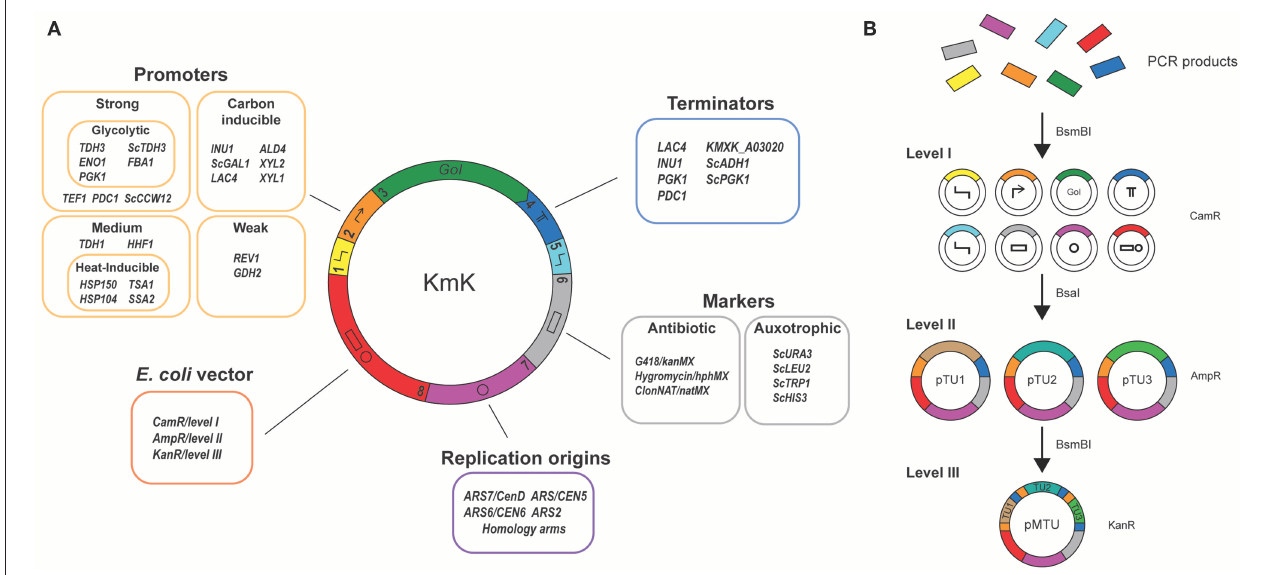
FIGURE 1 | A collection of biological parts and synthetic biology tools for Kluyveromyces marxianus . (A) The Kluyveromyces Kit (KmK) provides parts according to the Yeast Toolkit (YTK) standard to express any gene of interest (GoI) under various conditions and expression platforms. Several constitutive and inducible promoters allow precise expression of a GoI under different conditions specific to K. marxianus , and terminator choice further fine-tunes gene expression. A number of metabolic and antibiotic markers can be used in wild-type yeast, or in auxotrophs generated by the CRISPR/Cas9 system provided. Finally, a number of species-specific origins and integration homology arms allow the expression of the GoI on a stable plasmid or as an integration cassette. (B) Hierarchy of YTK assemblies. Alternating the type IIS enzymes between assemblies allows construction of different plasmid “levels.” Starting from amplified PCR products, parts are cloned into level I plasmids for storage. At the time of cloning, they are given overhangs corresponding to the numbered parts used to build expression systems. From there, individual transcriptional units are built from level I plasmids either for use or for storage; these are level II plasmids. Finally, multiple TU-bearing level II plasmids can be combined to create multi-TU level III plasmids that are either episomal or integrative vectors. The use of different bacterial markers at each level allows us to use the previous level’s plasmids directly for assembly.